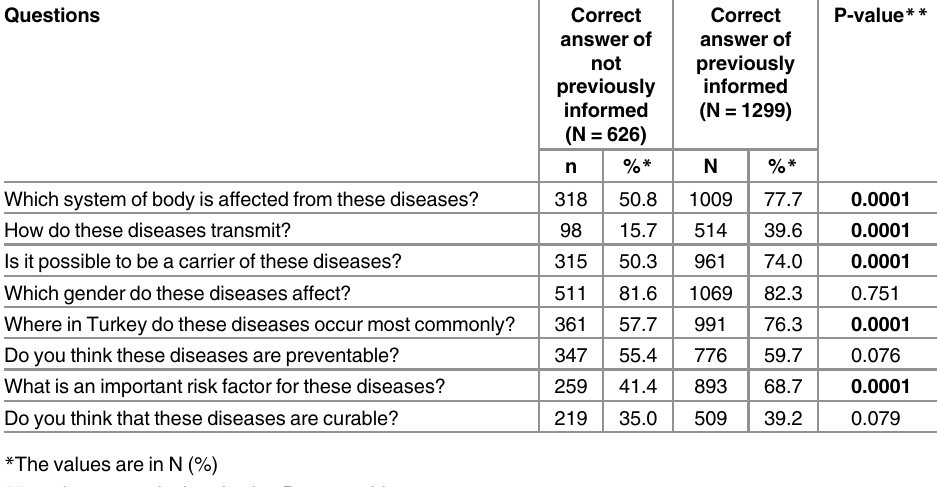
Table 1. Students ’ correct answer rate according to their status of being previously